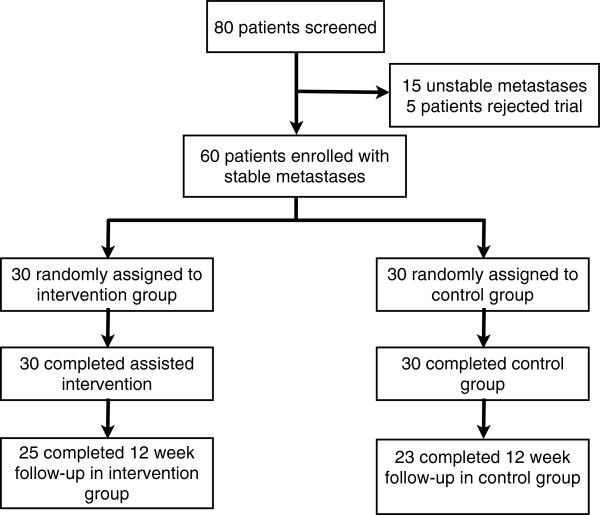
Flow of participants through the trial.